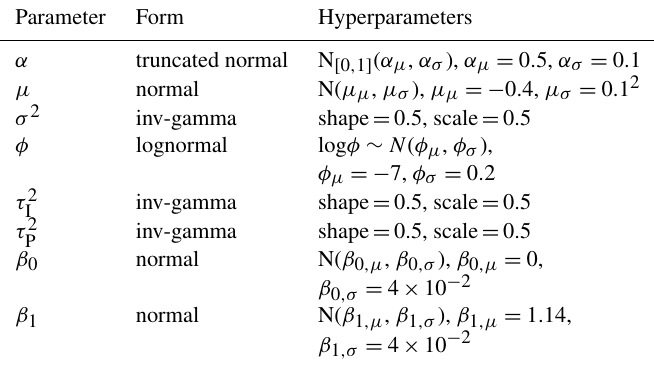
Table C1. List of parameters defined in BARCAST, form of prior and hyperparameters.